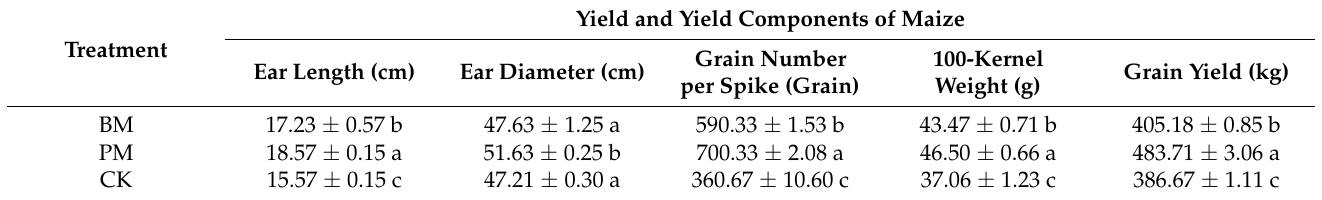
Table 3. Correlation between maize grain yield and covering materials in four growth stages.